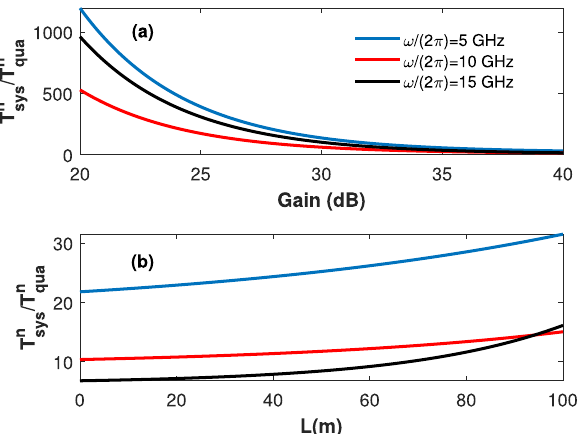
Figure 3. ( a ) The normalized system noise temperature (with respect to the quantum-limit noise temperature) versus the gain. Here, the waveguide length l = 100 m, the transmittance T r = 1 , and three different signal frequencies are considered. ( b ) The normalized system noise temperature (with respect to the quantum-limit noise temperature) versus the waveguide length. Here, the gain G = 40 dB, the transmittance T r = 1 , and three different signal frequencies are